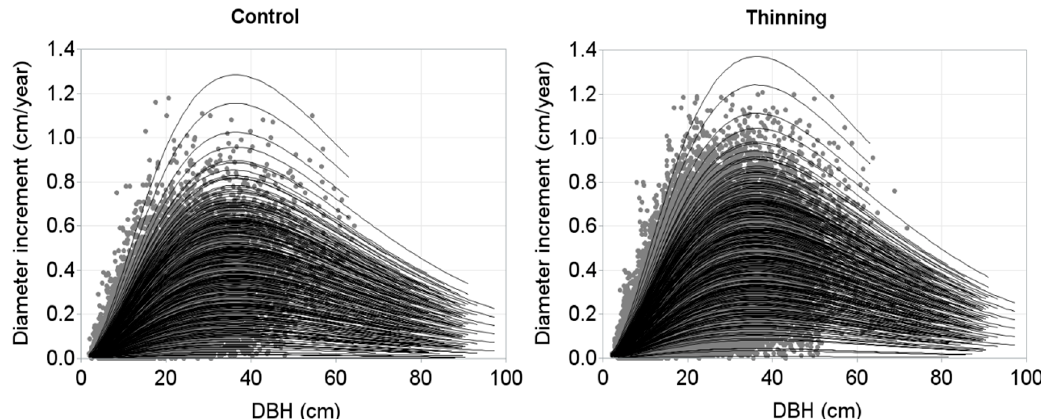
Figure 6. Sample plot-specific diameter increment curves overlaid on the measured diameter increment data. Sample plot mean of the covariate predictors, except the dominant height (HDOM), which was allowed varying from approximately minimum to maximum by 2 m in the measured data, were used to produce the curves. Model was calibrated with the random effects estimated using the measured diameter increment of four randomly selected trees per sample plot; DBH: diameter at breast height.